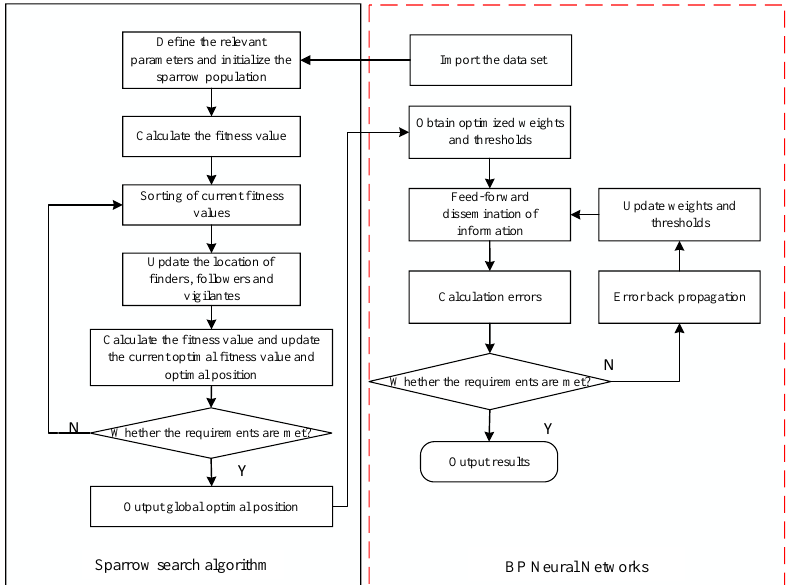
Figure 10. The algorithm flow of the optimized BPNN based on the sparrow search algorithm.